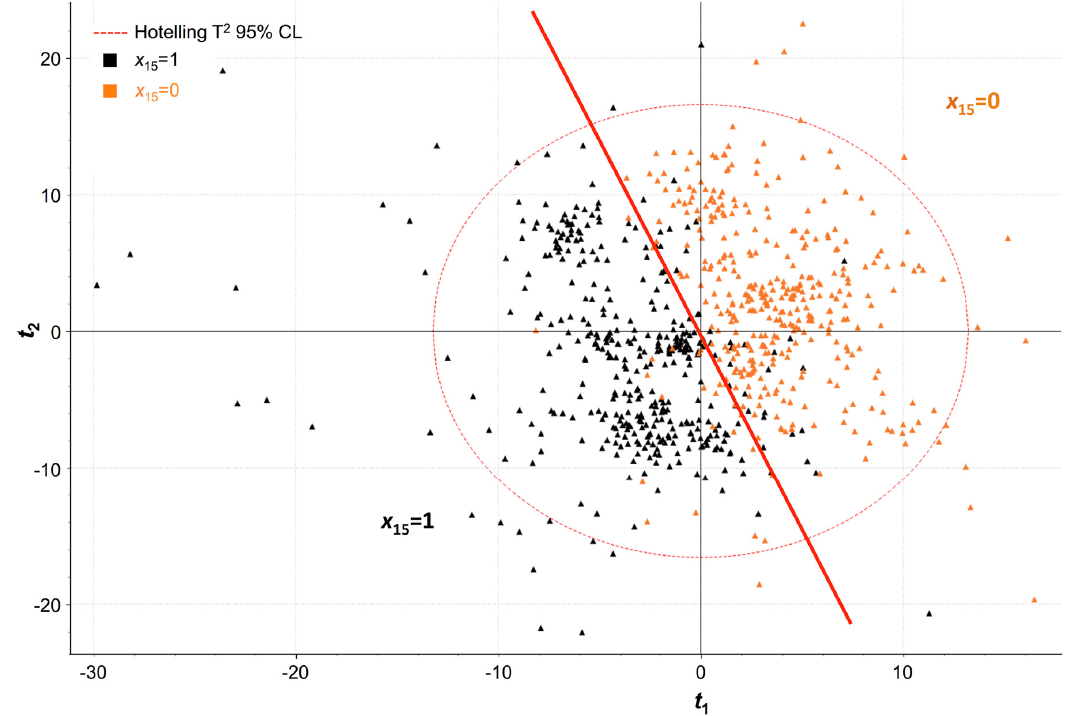
Figure 11. Scores plot for the two first LVs ( t 2 vs. t 1 ) for the PLS-discriminant analysis (DA) regression model fitted with eight LVs [R 2 (Y) = 79.80%; Q 2 (Y) = 71.90%], showing the separation between batches with x 15 = 0 (orange; right side of the red straight line) and x 15 = 1 (black; left side of the red straight line).